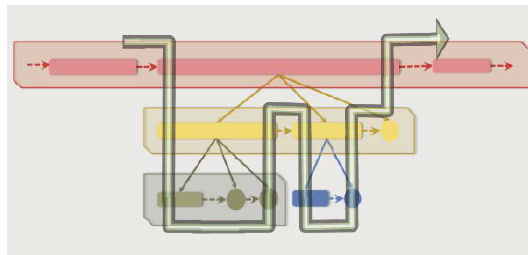
Figure 3. A user interface in a historical story visualization system is composed of displays of maps, timelines and articles.